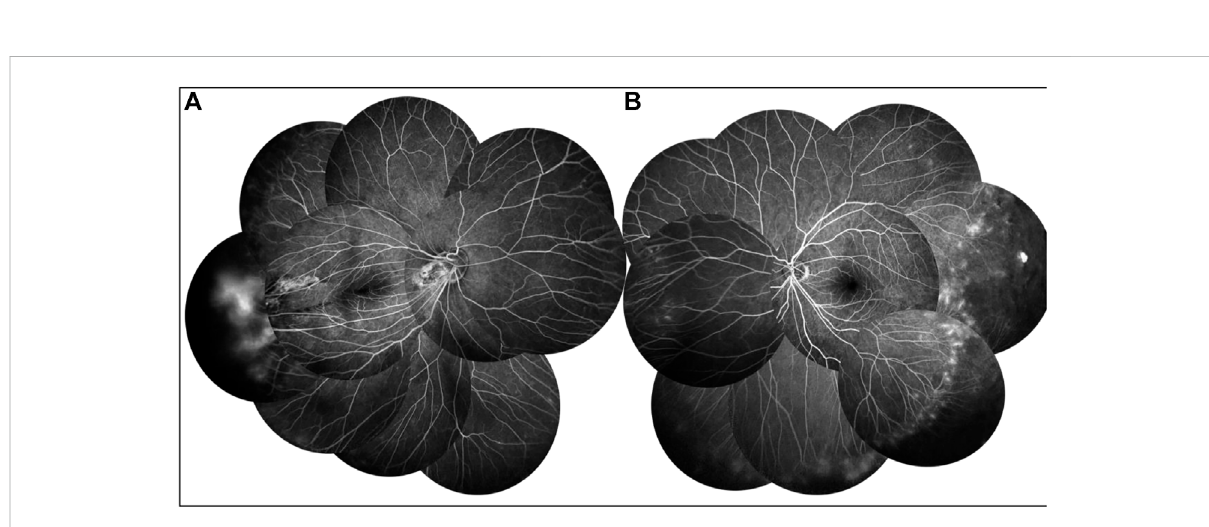
FIGURE 5 FFAofproband ’ sfathershowedalargeavascularzoneinthebilateraltemporalperipheralretina,andbloodvesselsintheperipheralretinalwere fl at and numerous (A,B) . The temporal peripheral retina showed patchy high fl uorescence with fl uorescein leakage, which is obvious in the right (B)